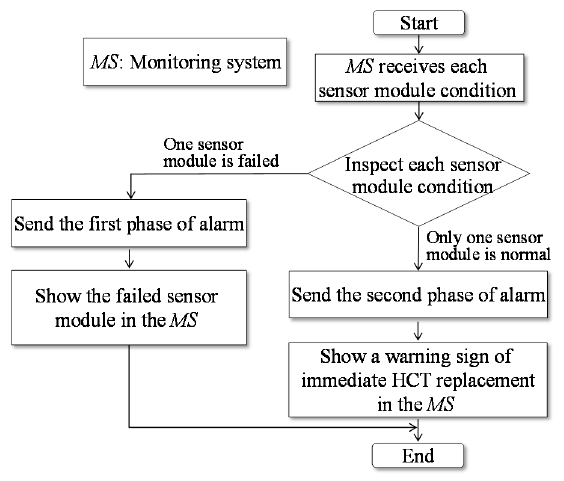
Figure 8. Flowchart of sensor module failure alarm function unit.